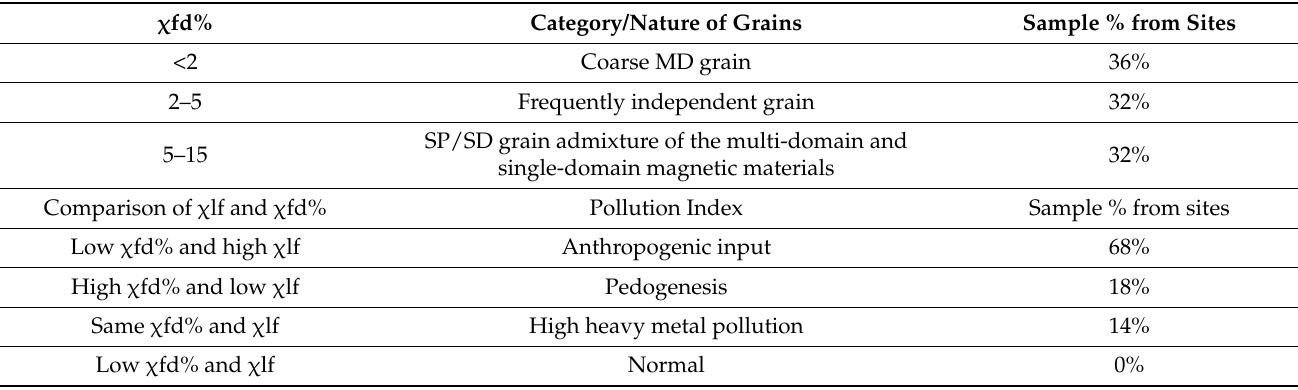
Table 1. Environmental magnetism through interpretation of the susceptibility values of frequency dependence and mass-specific low magnetic susceptibility to identify the domain nature of the grains in the study area followed by